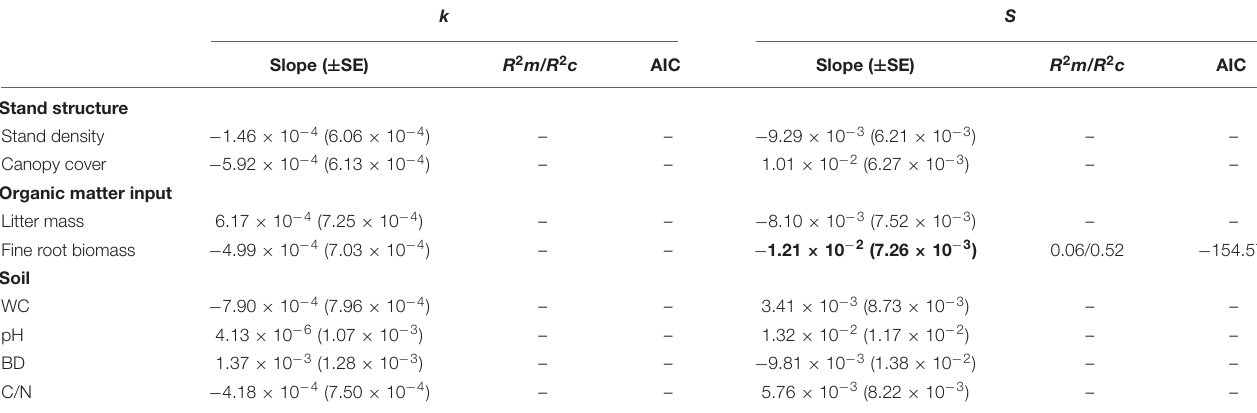
FIGURE 1 | Johnson-Neyman plots showing the interactions between temperature and precipitation on the initial decomposition rate ( k ) in the (A) temporal climate and (B) long-term climate model. Dash lines show the temperature thresholds at which there are significant changes in the effect of precipitation on k . TABLE 4 | Results of multiple linear mixed models testing the effects of stand structure, organic matter input, and soil parameters on k and S